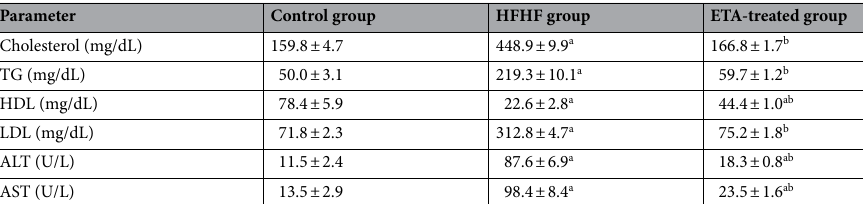
Table 2. ETA reduces HFHF-induced elevation in serum liver function parameters and lipid profile. Data are presented as mean ± SD values and are representative of a single independent experiment ( n = 6). Statistical analysis was performed using one-way ANOVA, followed by Tukey’s multiple comparison tests. a Significantly different from the control group. b Significantly different from the HFHF group. Differences were considered significant if the p-value was < 0.05. ALT alanine aminotransferase, AST aspartate aminotransferase, ETA etanercept, HFHF high-fat high-fructose diet, HDL high-density lipoprotein, LDL low-density lipoprotein, TG